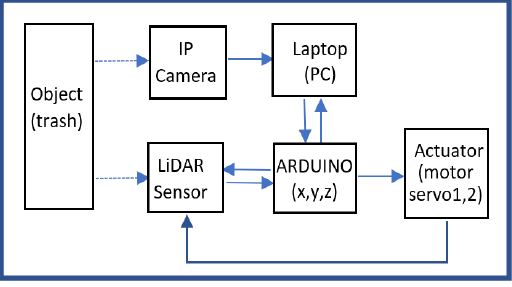
Figure 4. Block diagram.